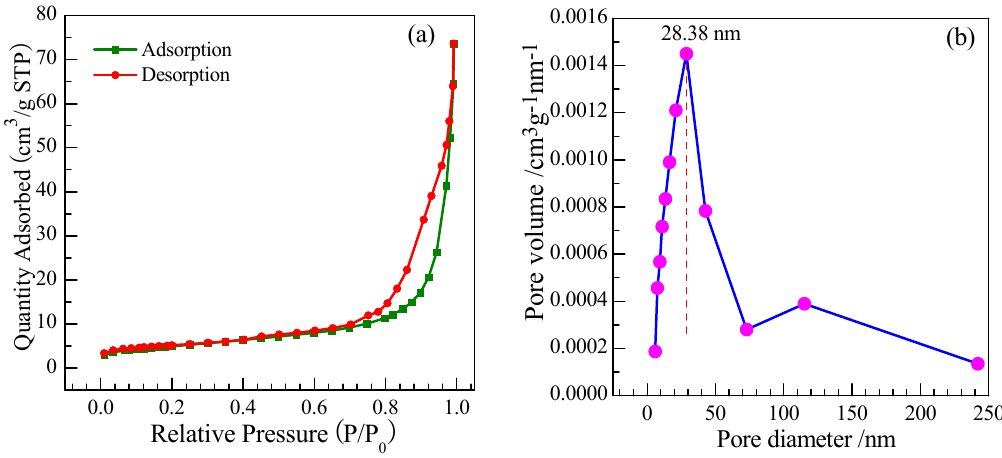
Figure 7. ( a ) N 2 adsorption-desorption isotherm; ( b ) Barrett-Joyner-Halenda (BJH) pore size distribution plot.